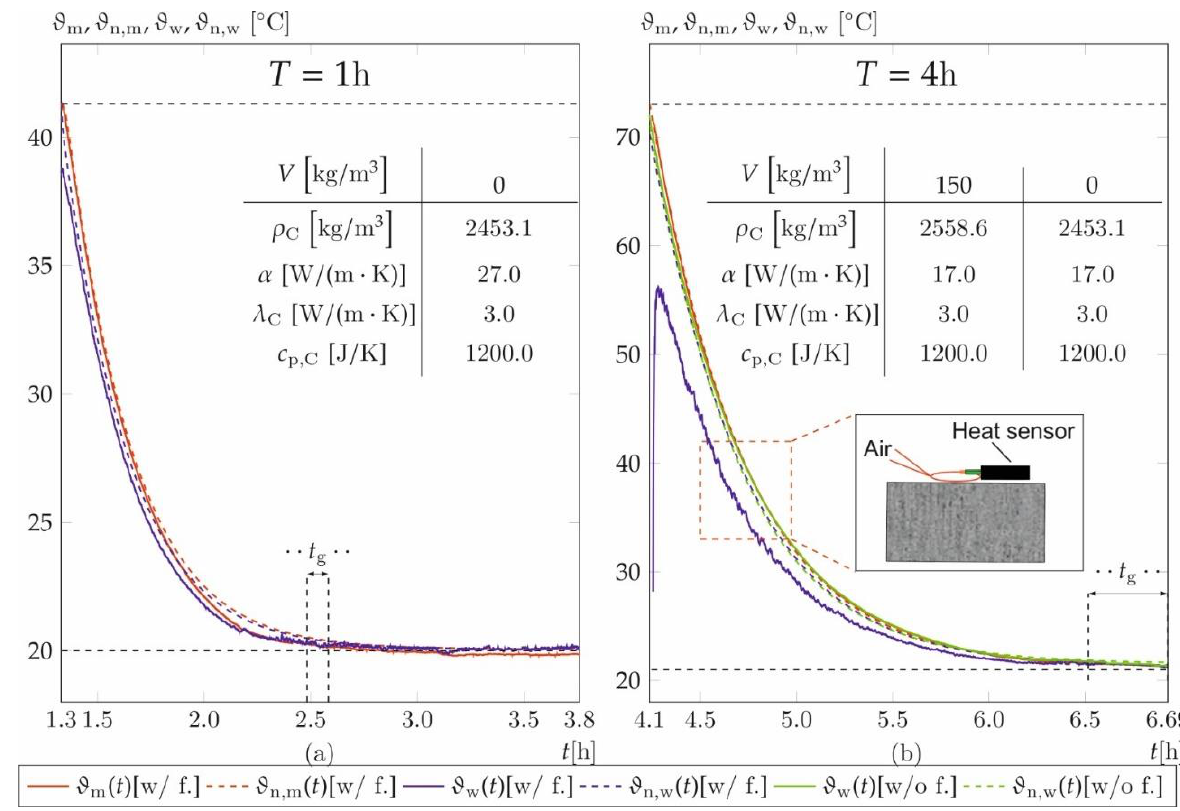
Figure 8. Comparison of measured core ϑ m and surface temperatures ϑ w along with the numerical expectations of core ϑ n,m and surface temperatures ϑ n,w of prisms for T = 1 h ( a ) and T = 4 h ( b ), respectively.